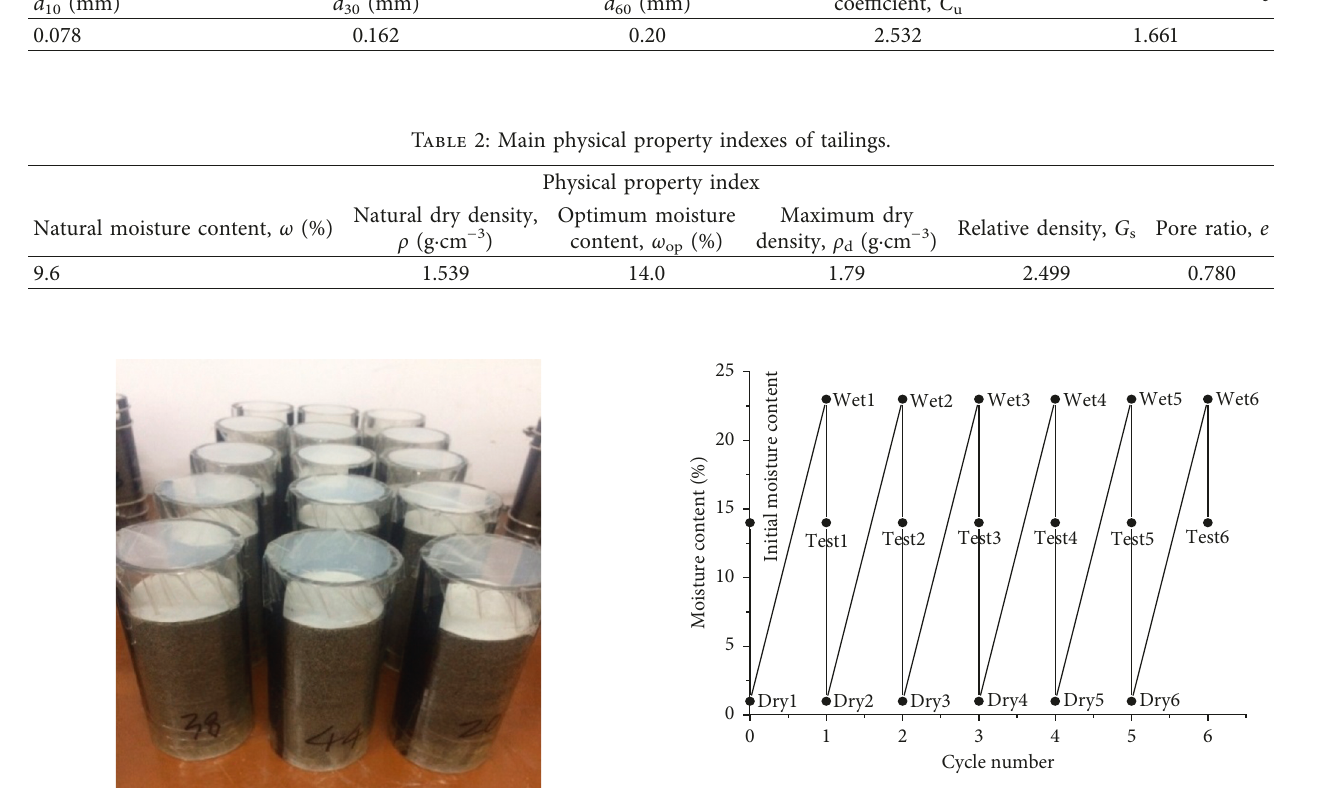
Figure 4: Schematic diagram of the dry and wet cycle.